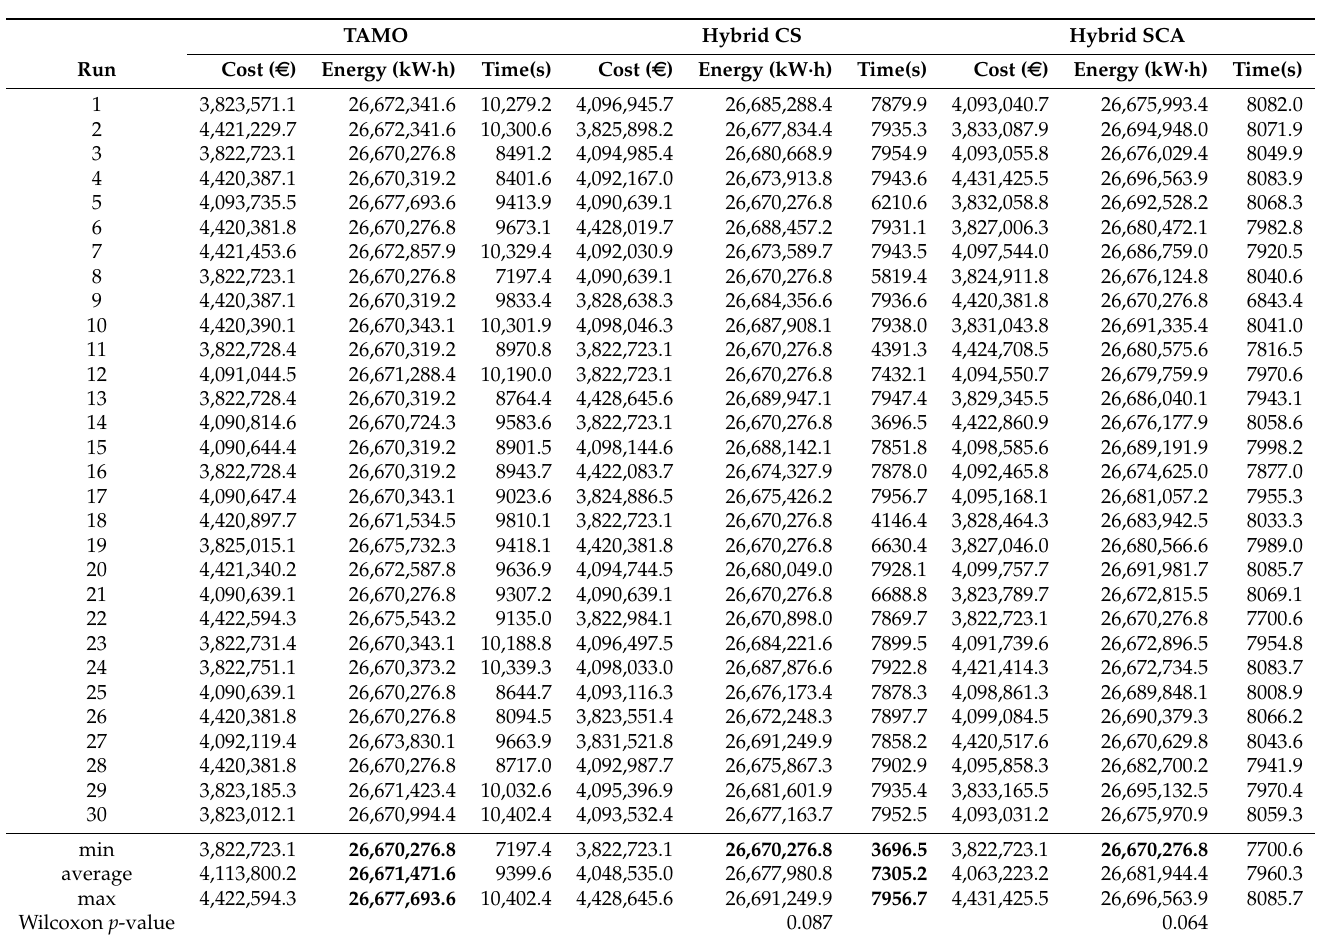
Table 8. Embodied energy minimization results for 30 executions of TAMO, hybrid CS, and hybrid SCA